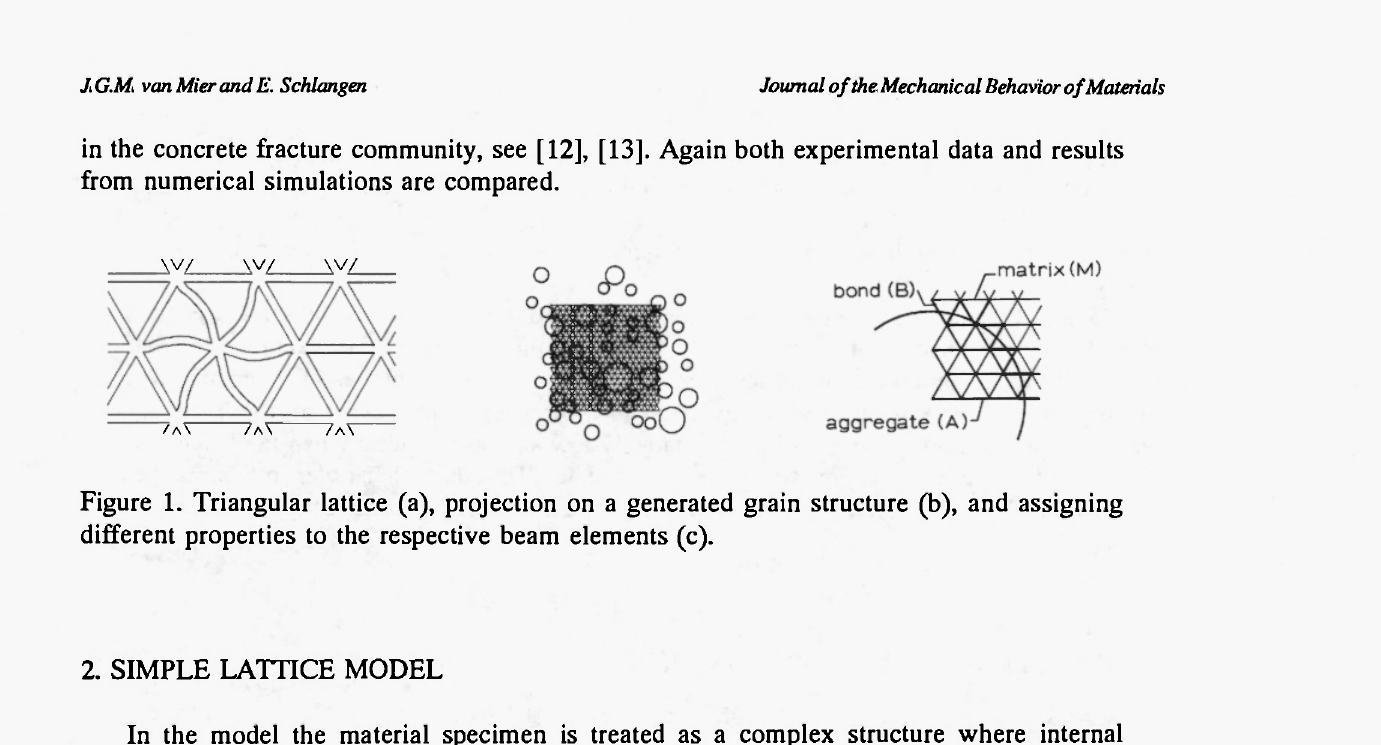
Figure 1. Triangular lattice (a), projection on a generated grain structure (b), and assigning different properties to the respective beam elements